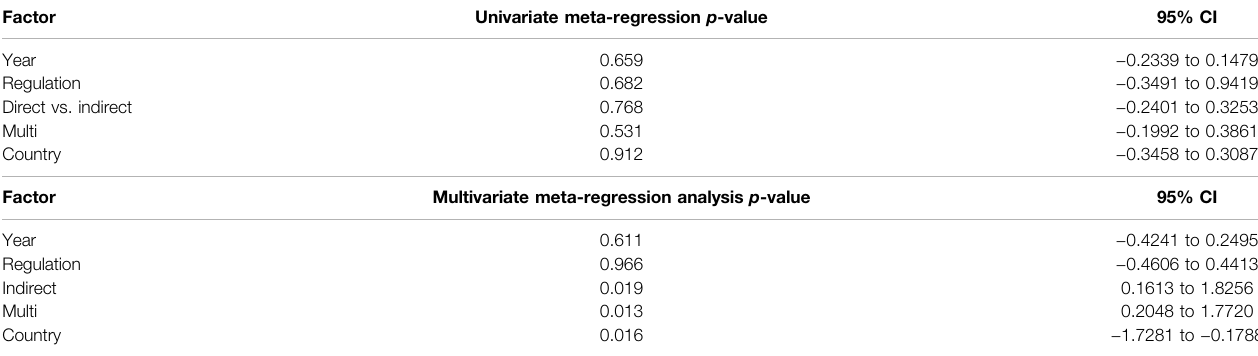
TABLE 3 | Meta-regression analysis of the included studies. Factor Univariate meta-regression p -value